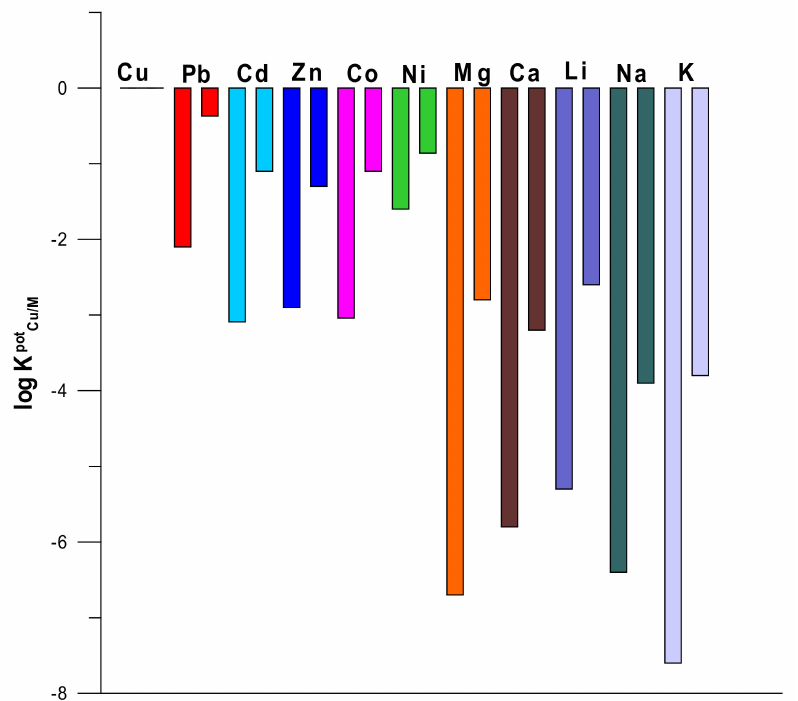
Figure 9. Comparison of selectivity coefficients of nanocomposite-based electrode 4 (1st column) and unmodified electrode 1 (2nd column).